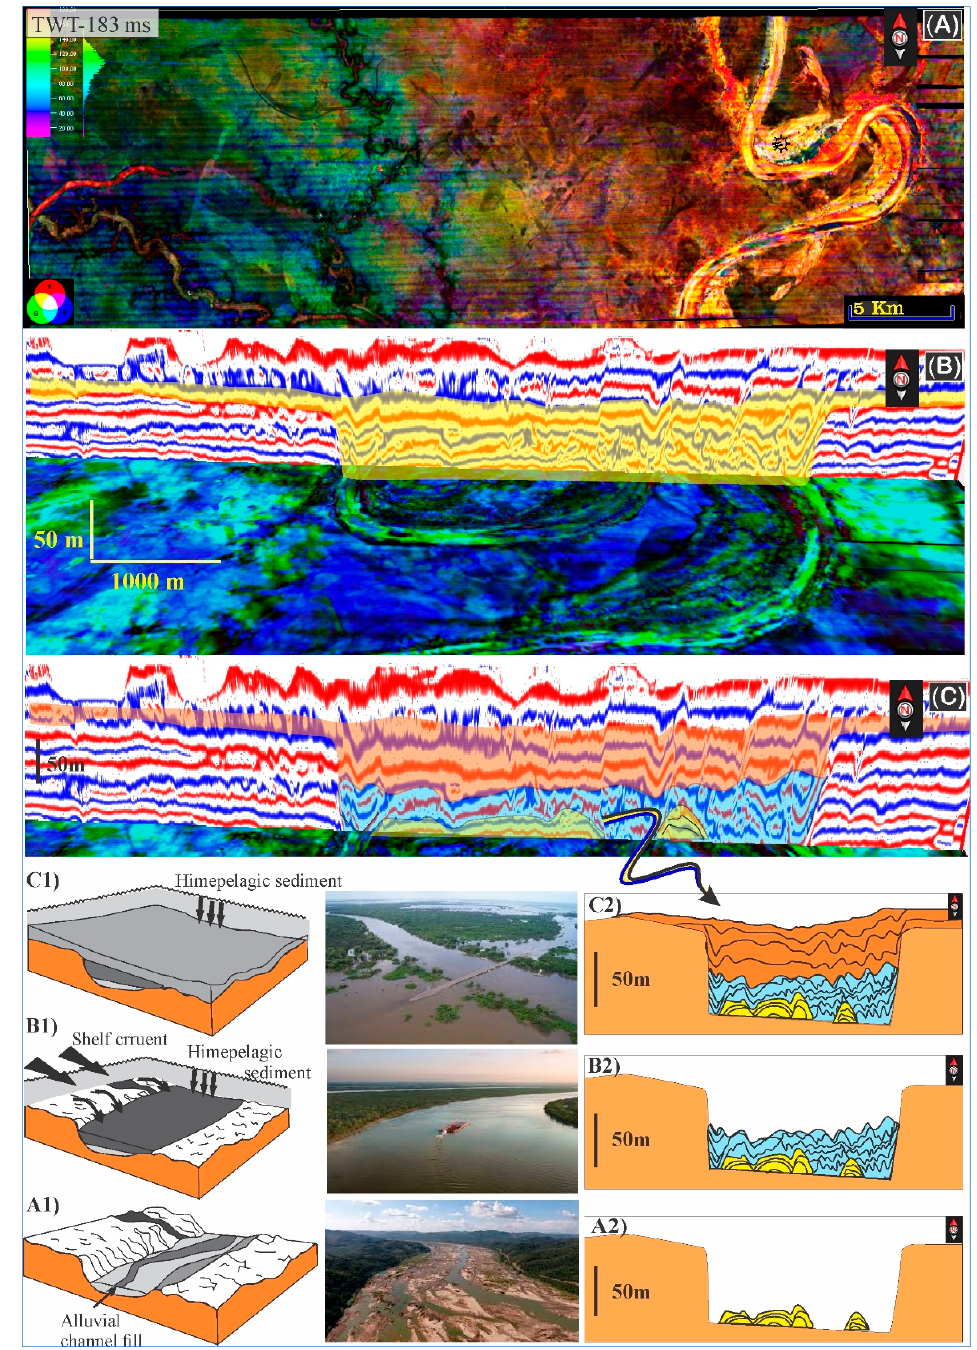
Figure 15. The RGB color blending time slice and Cosine of Phase seismic attribute cross-line through the incised channel, showing the evolution of three separate valley-fill stages: ( A ) accumulation of point bars throughout active fluvial sediments Lowstand Systems Tract (LST). ( B ) Transgressive sediments inactively forming reflection of onlaps against the channel walls. ( C ) Sediments of open-marine high stand covering the whole carved-valley complex. ( A1 , A2 ), ( B1 , B2 ), and ( C1 , C2 ) are simulation diagrams that show the incised valley evolution.